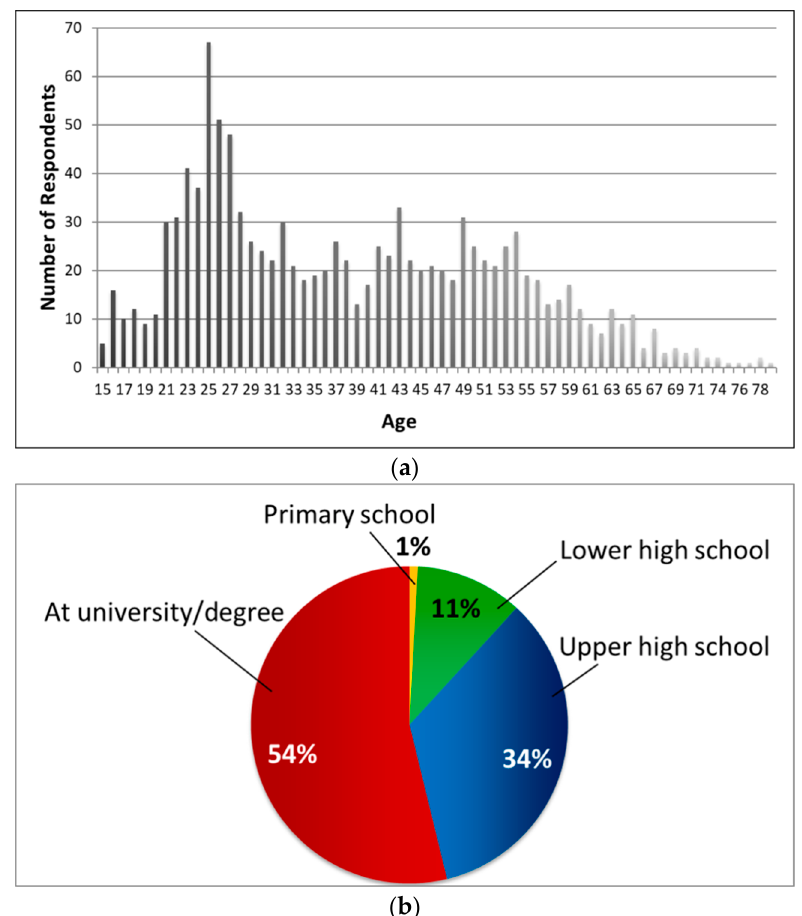
Figure 1. Questionnaire. ( a ) Age distribution of the samples involved in the questionnaire. ( b ) Pie chart of the percentages of the sample based on their level of education.